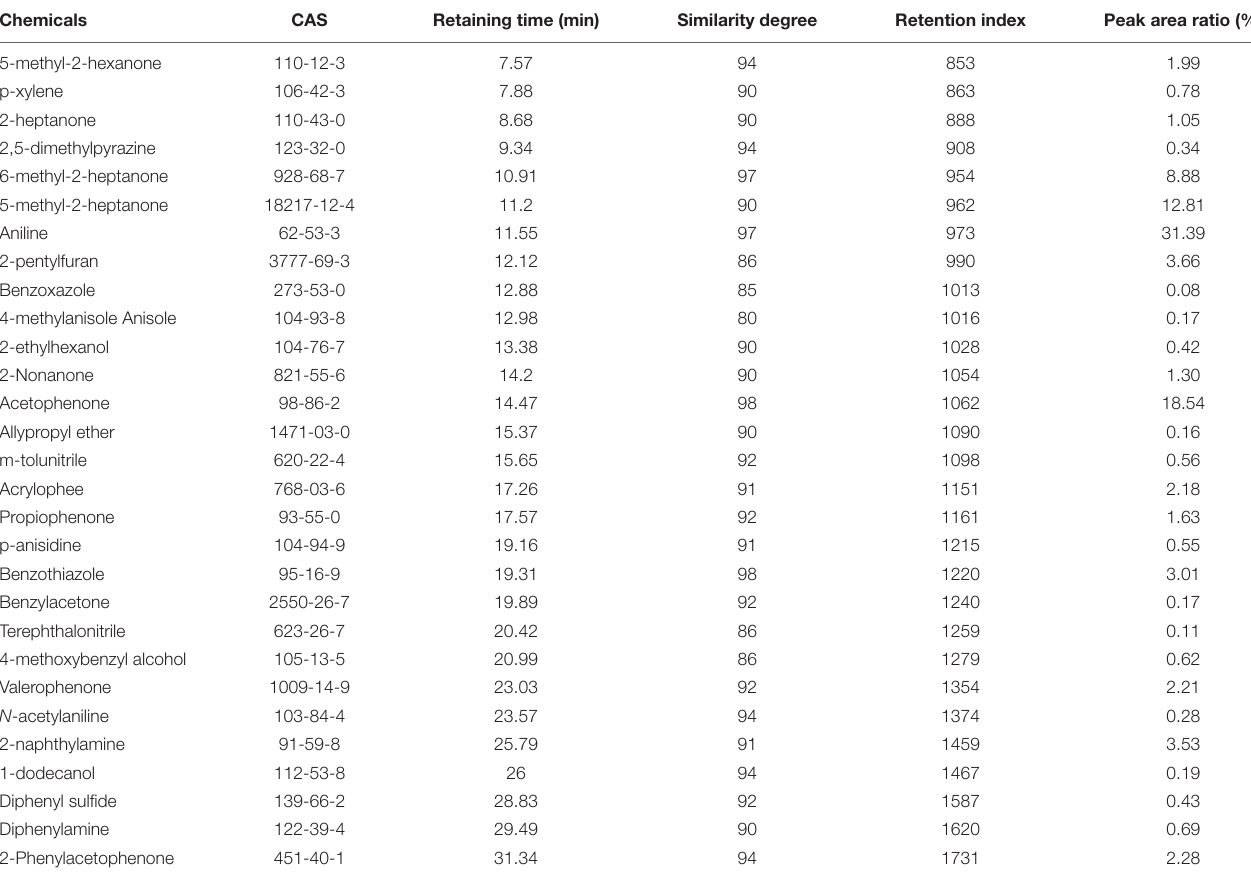
TABLE 1 | Volatile compounds produced by B. subtilis